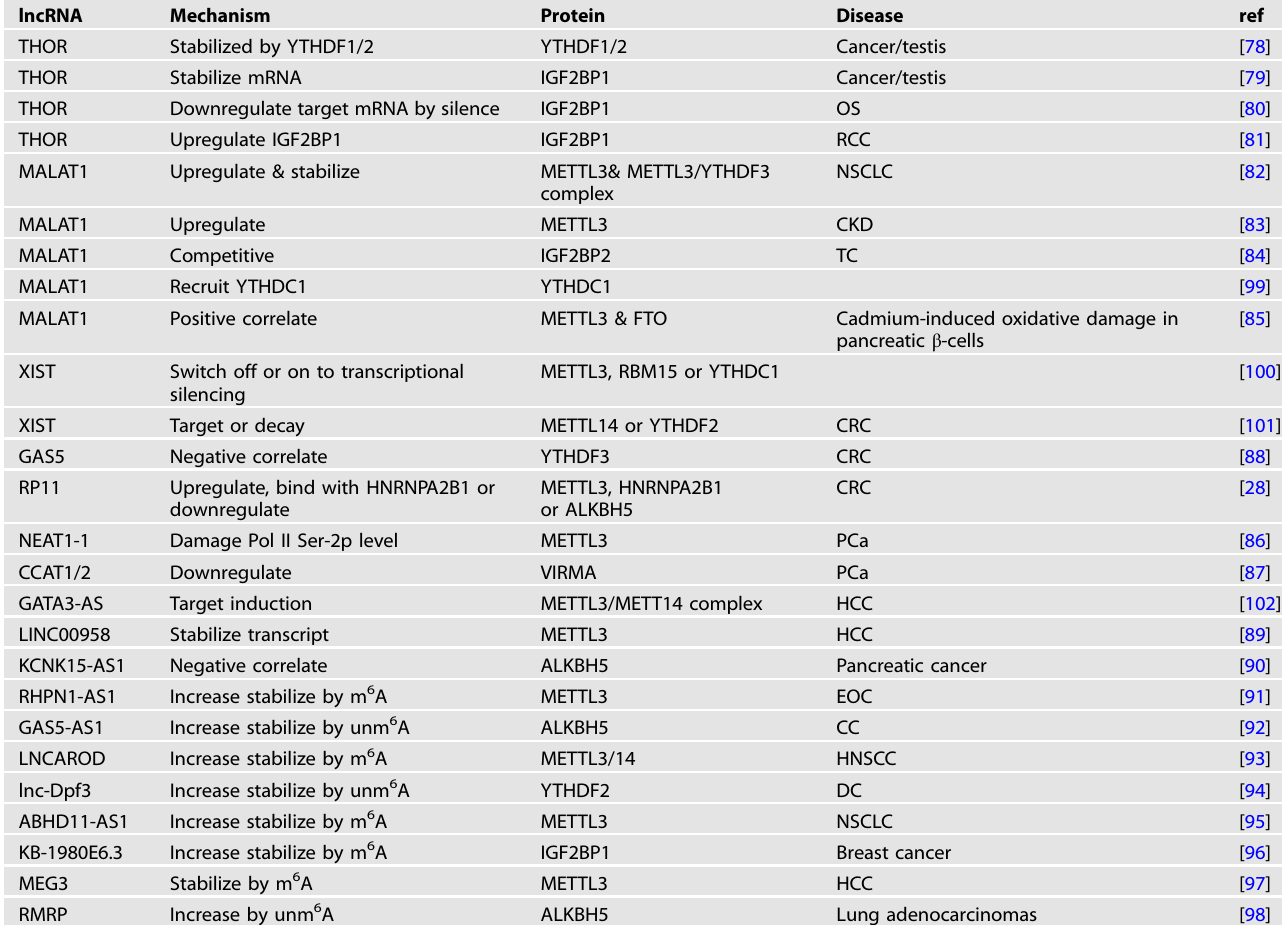
Table 2. The interactions between lncRNAs and m 6 A modi fi